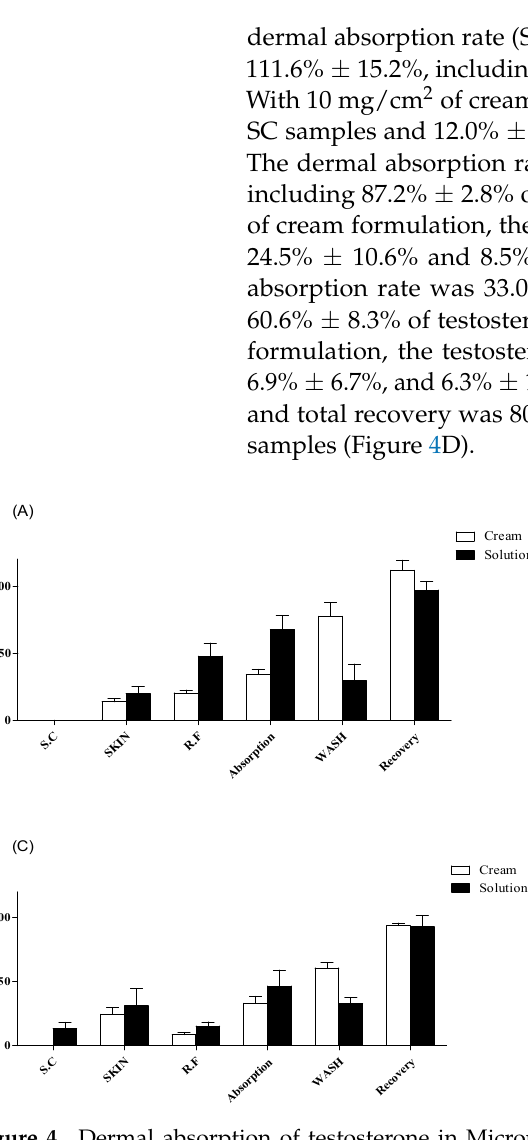
Figure 4. Dermal absorption of testosterone in Micropig ® skins (n = 4, mean ± SD). Dermal absorption test results with applied doses of ( A ) 5 mg/cm 2 or 5 µ L/cm 2 , ( B ) 10 mg/cm 2 or 10 µ L/cm 2 , ( C ) 25 mg/cm 2 or 25 µ L/cm 2 , and ( D ) 50 mg/cm 2 or 50 µ L/cm 2 . SC, stratum corneum; SKIN, dermis and epidermis; RF, receptor fluid; WASH, remaining formulation rinsed using alcohol swabs.